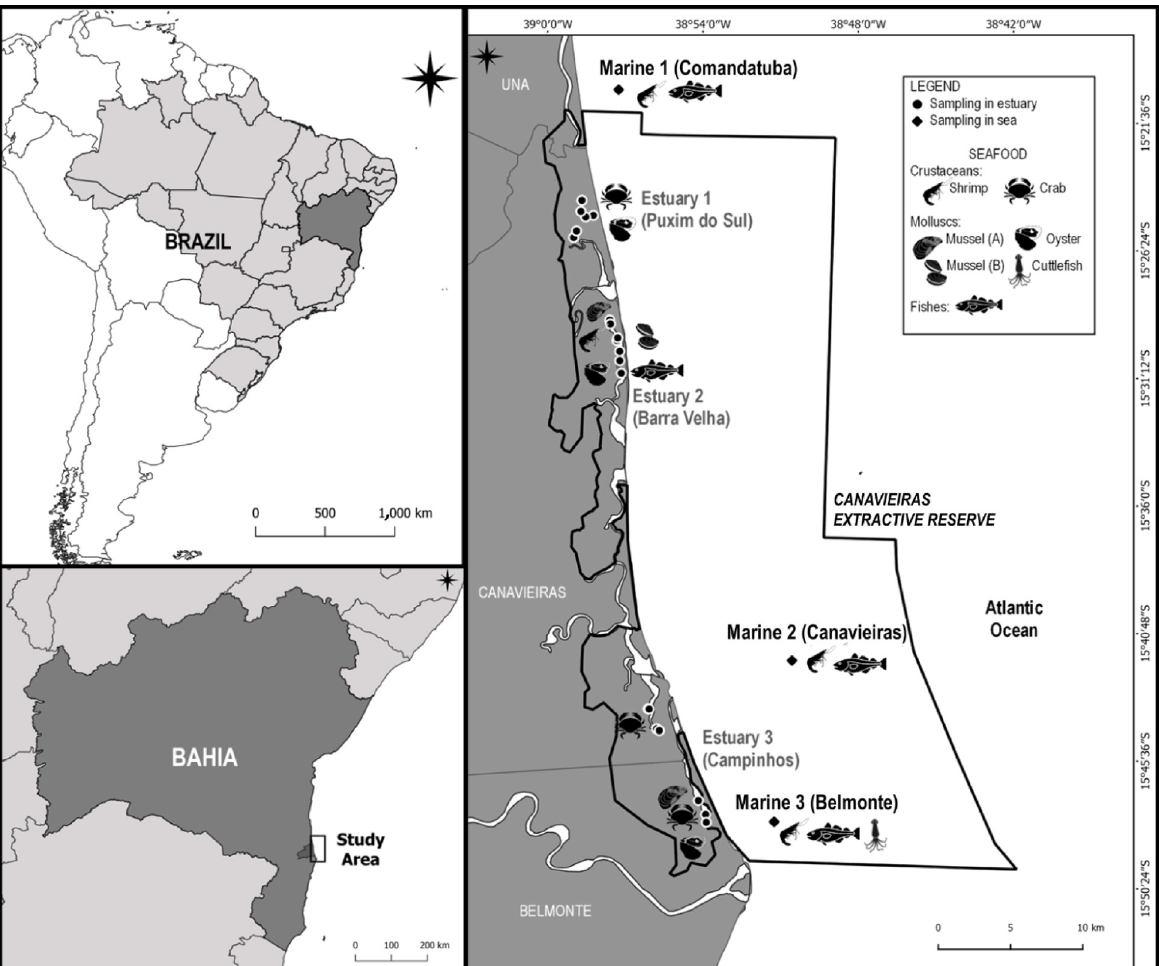
Figure 1. Location of sampling stations in estuaries (3 sites) and sea (3 sites), as well as the sampling biota in the Canavieiras region. Crustaceans: shrimps and crabs; molluscs: mussels, shellfishes, oysters and squid; and